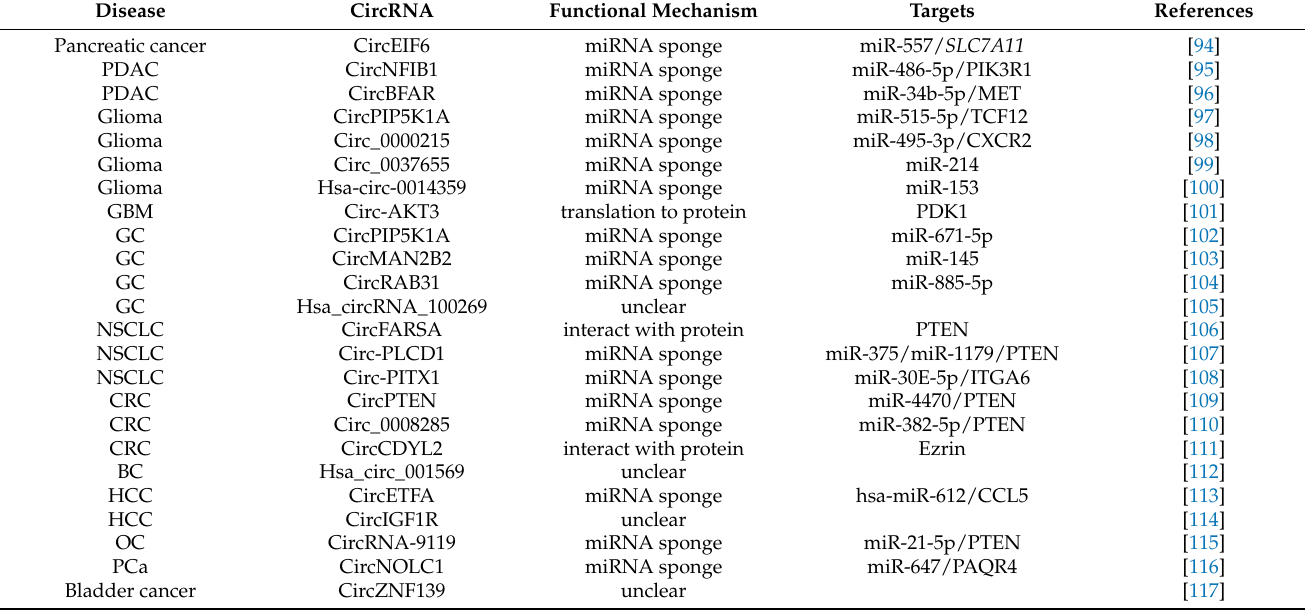
Table 1. CircRNAs that regulate age-related diseases via the PI3K/Akt signaling pathway.